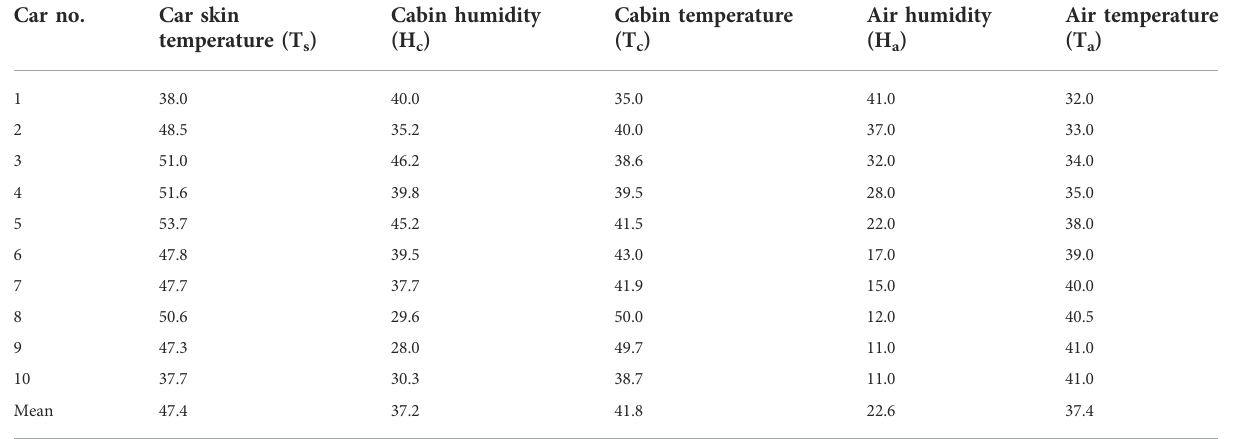
TABLE 1 Thermal pro fi ling of car skin, car cabin, and the surrounding air. Car